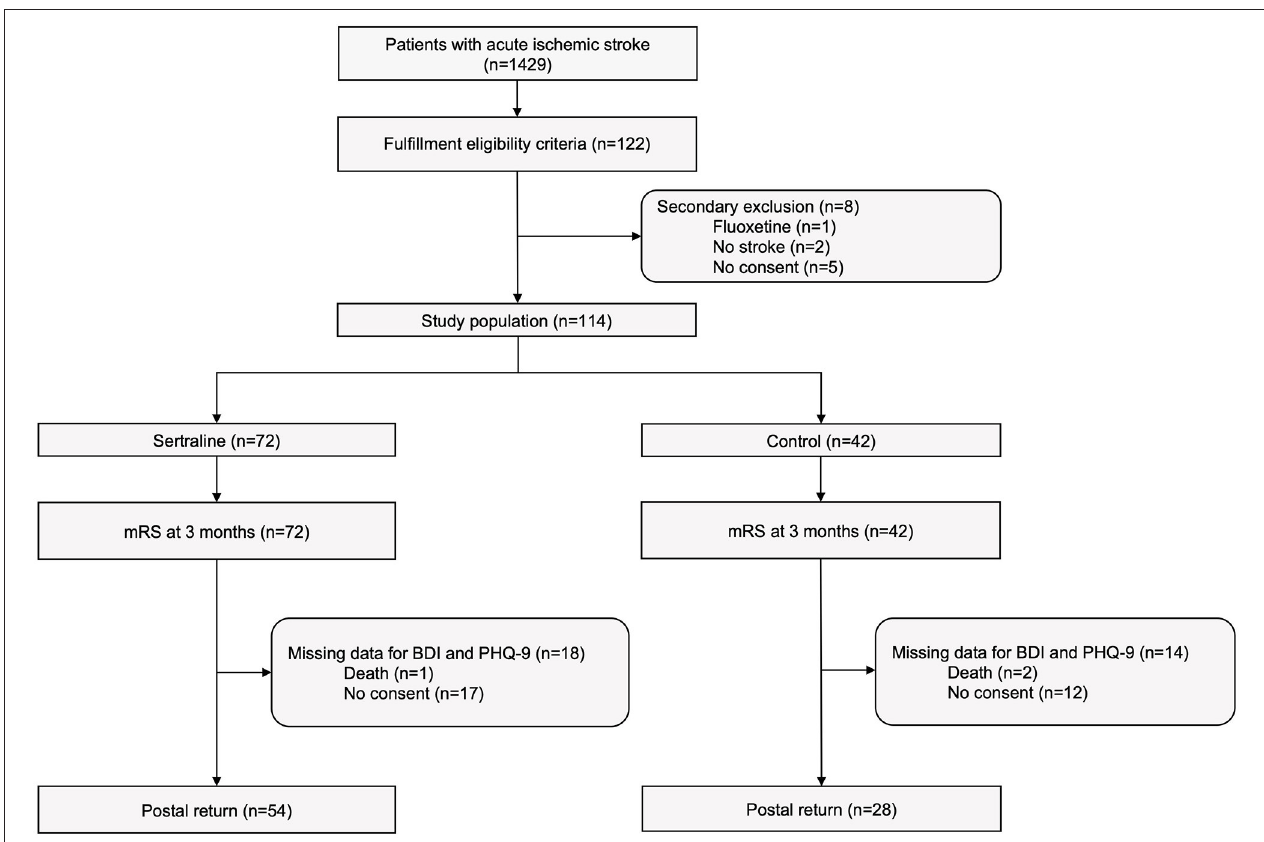
FIGURE 1 | Study flow